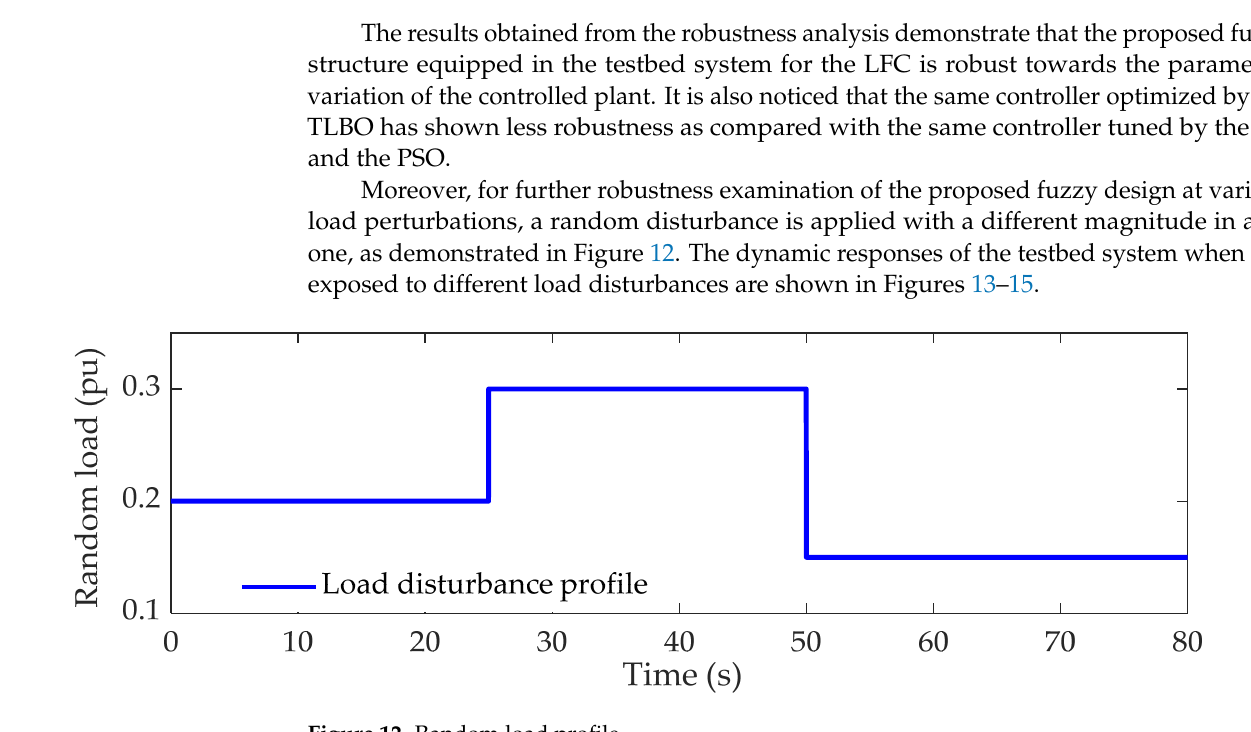
Figure 11. Tie-line power deviation ( ∆ P tie in pu) under parametric uncertainties of the testbed sys- tem.